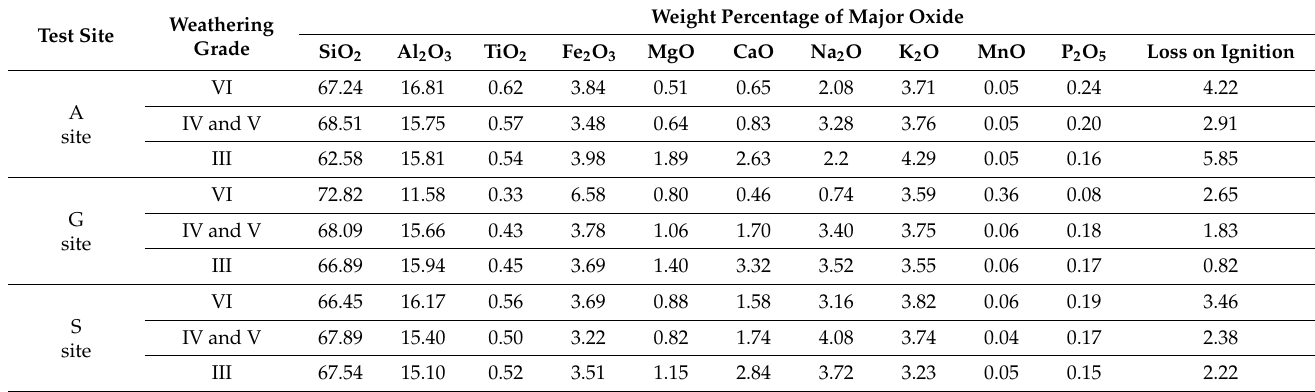
Table 3. Average weight percentage of major oxide.